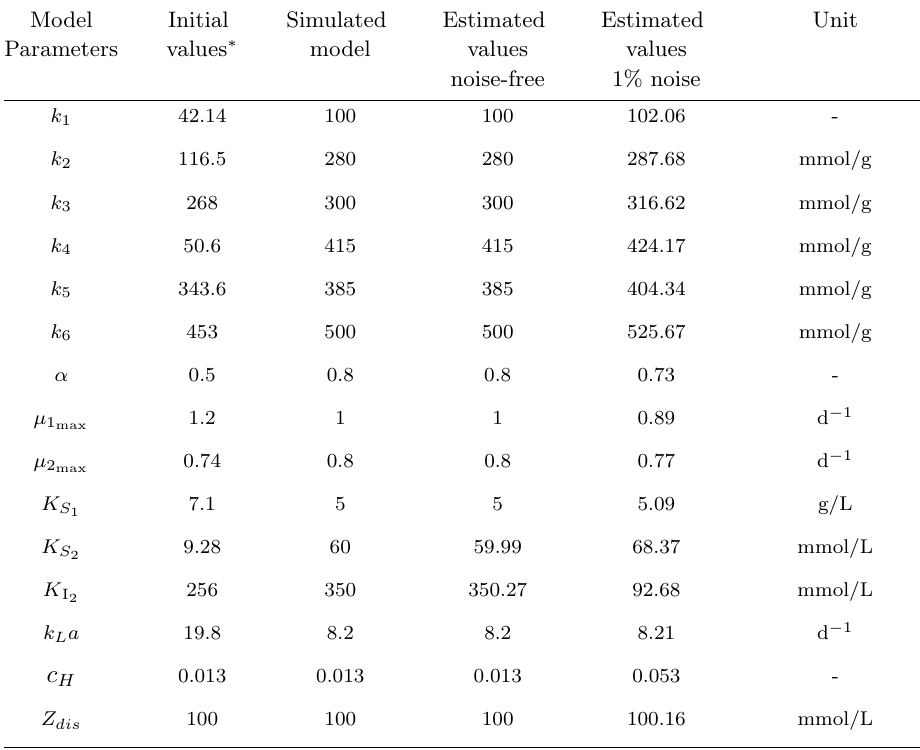
Table 3: Model parameter values for simulation model, initial states and estimated values with and without added simulated measurement noise